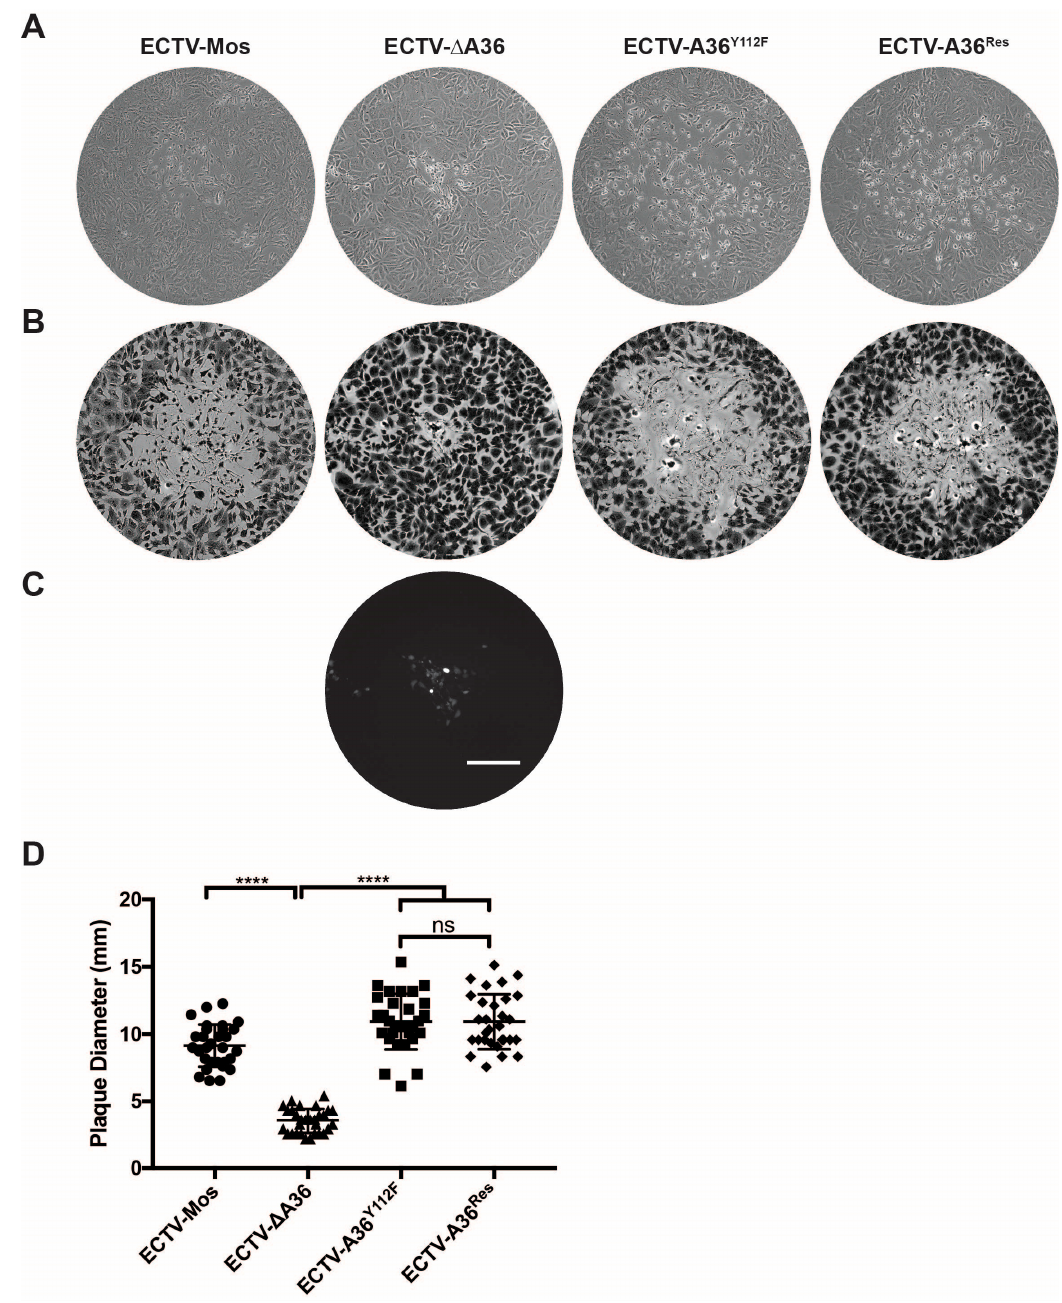
Figure 4. Actin-based motility does not contribute to cell-to-cell spread. Plaque assays were performed in BSC-1 monolayers infected with serially diluted virus and overlaid with 1.5% carboxymethyl cellulose in minimal essential medium (CMC-MEM). At six days pi, plaques were visualized by: phase contrast microscopy ( A ); and fluorescence microscopy for ECTV- Δ A36 ( C ); and then stained with crystal violet ( B ). Scale bar: 200 μ m. ( D ) The diameter of each plaque was measured as the widest point across which cytopathic effects were observed. Data for two experimental replicates were pooled ( n = 30). (**** p < 0.0001; ns, non-significant; unpaired t -test).